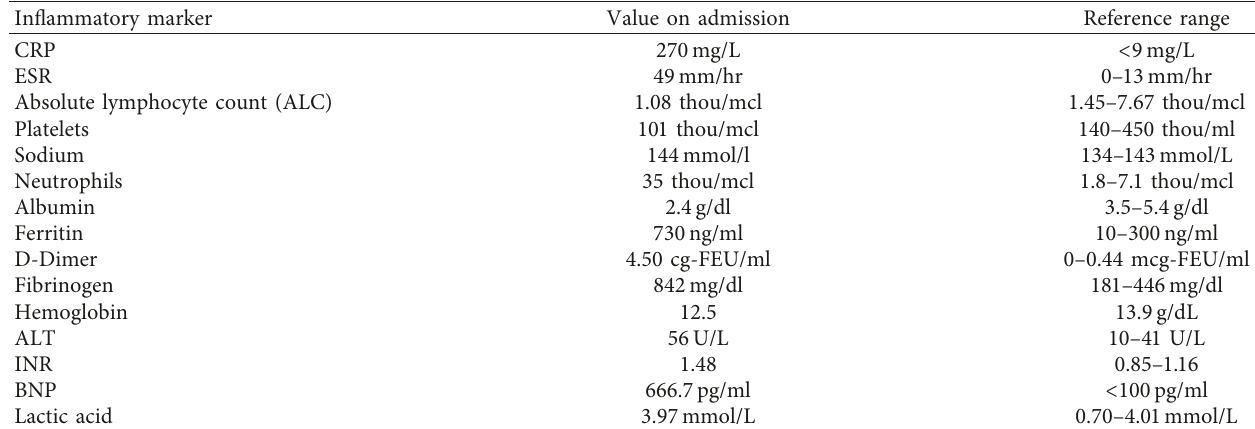
Table 1: Laboratory values on admission.